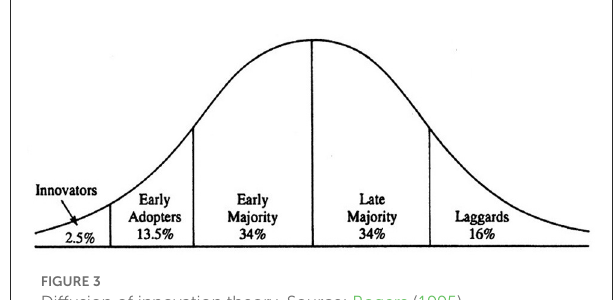
FIGURE3 Diffusion of innovation theory. Source: Rogers (1995).